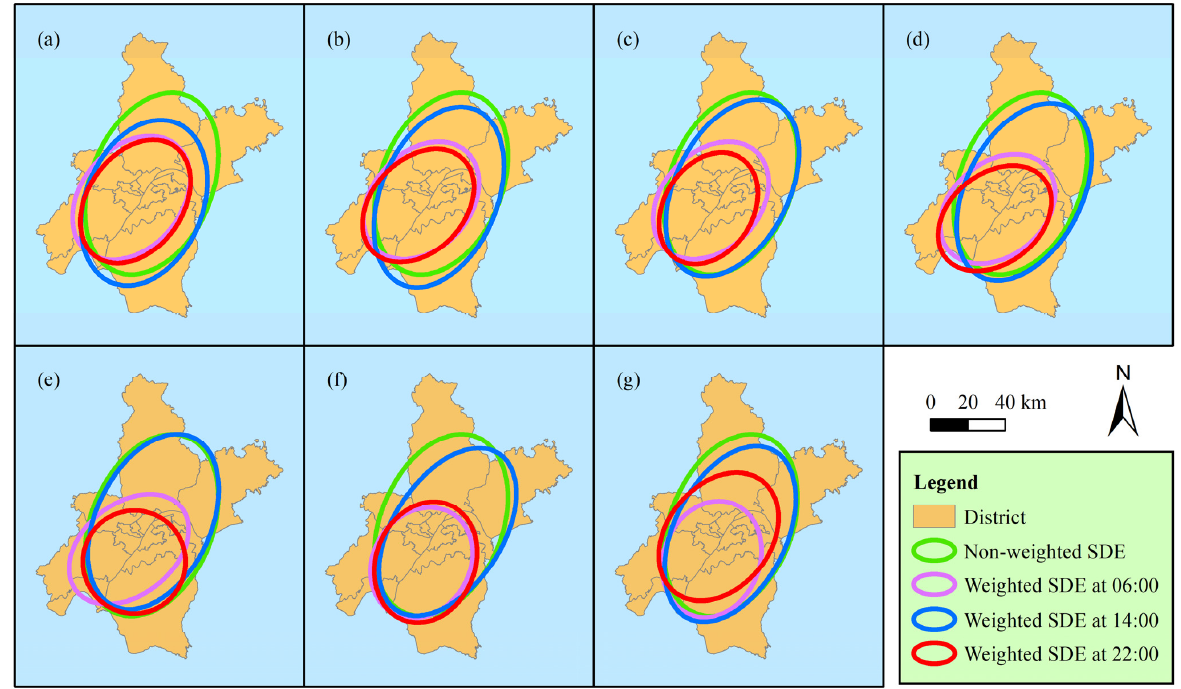
Figure 5. The SDEs of the city of Wuhan. ( a ) 17 July; ( b ) 18 July; ( c ) 19 July; ( d ) 20 July; ( e ) 21 July;